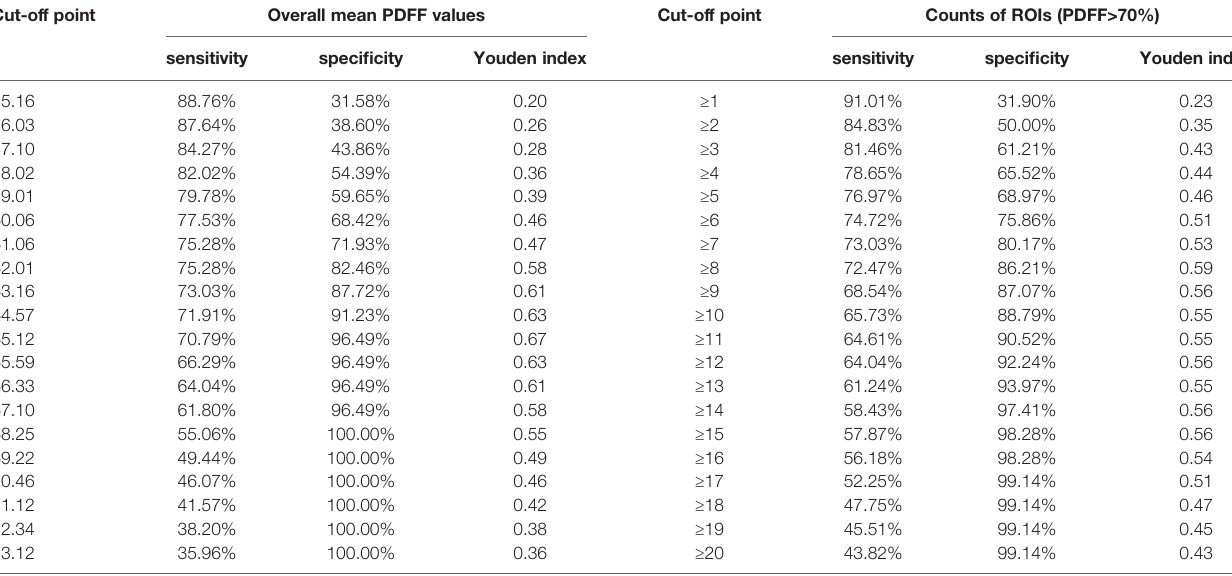
TABLE 4 | Determination of cut-off levels for overall mean PDFF values and counts of ROIs (PDFF>70%). Cut-off point